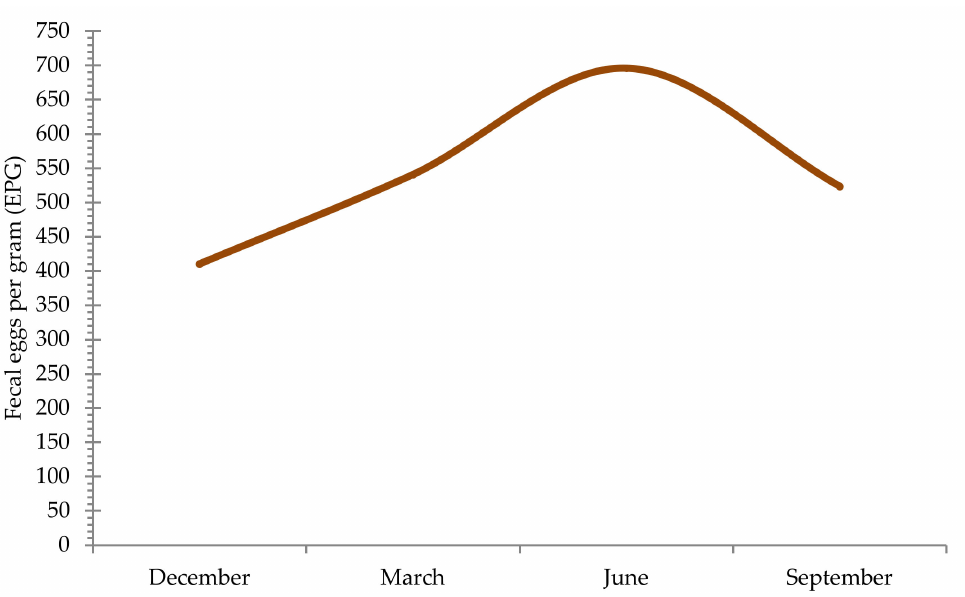
Figure 5. Annual average curve of Strongylid egg excretion between 2009 and 2014 in autochthonous Miranda do Douro donkeys in the northeast of